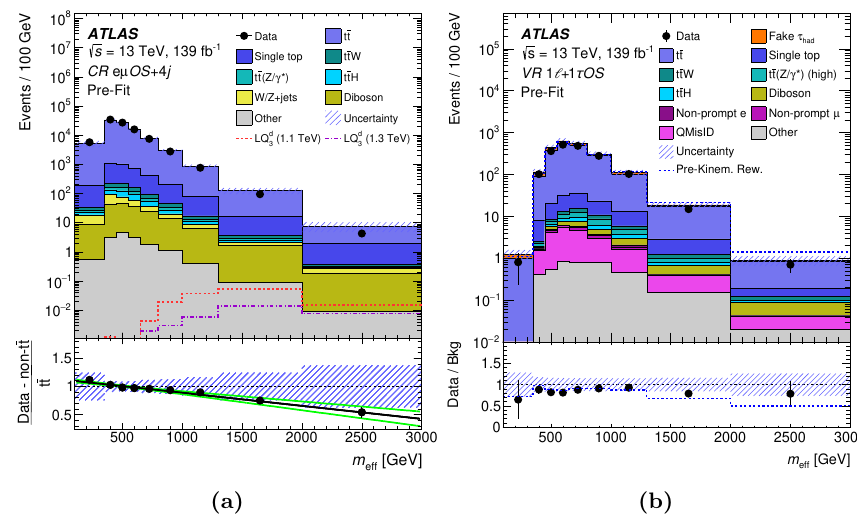
Figure 5. (a) Comparison between data and the background prediction for the m eff distribution in events selected by requiring an opposite-charge (OS) eµ pair, exactly four jets, and at least one b -tagged jet. The background contributions shown are before the likelihood fit to data (“Pre- Fit”). The lower panel displays the ratio of the data, after subtracting the small background contributions estimated from the simulation, to the predicted sum of t ¯ t and tW processes, along with the corresponding fit using a first-degree polynomial (black solid line). The associated green lines represent the estimated uncertainty in the reweighting function. (b) Comparison of the m distribution between data and the pre-fit background prediction after the kinematic reweighting in the 1 ‘ +1 τ OS VR. The total background prediction before the kinematic reweighting (“Pre-Kinem. Rew.”) is shown as a dashed blue histogram. The ratio of the data to the total pre-fit background prediction (“Bkg”) is shown in the lower panel. The size of the combined statistical and systematic uncertainty in the background prediction is indicated by the blue hatched band. The ratios of the data to the total pre-fit predictions before and after kinematic reweighting are shown in the lower panel. The last bin in each figure contains the